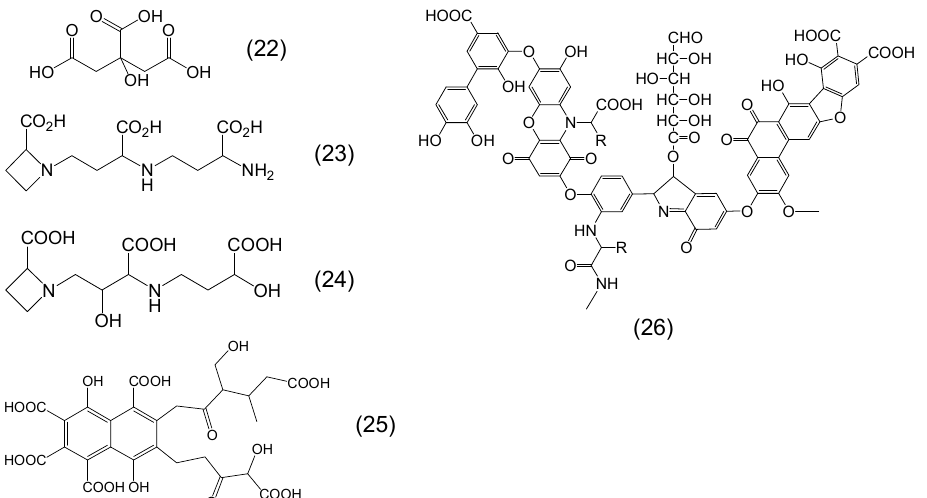
Figure 7. Examples of phytochelators containing the carboxylic acid as the metal binding site. Citric acid or 2-hydroxypropane-1,2,3-trioic acid ( 22 ), nicotianamine or N -( N -(3-amino-3-carboxypropyl)-3-amino-3-carboxypropyl)azetidine-2-carboxylic acid ( 23 ), mugineic acid or (2 S )-1-[(2 S ,3 S )-3-carboxy-3-[[(3 S )-3-carboxy-3-hydroxypropyl]amino]-2-hydroxypropyl]azetidine-2-carboxylic acid ( 24 ), fulvic acid or 3,7,8-trihydroxy-3-methyl-10-oxo-1,4-dihydropyrano[4,3-b]chromene-9-carboxylic acid ( 25 ) and humic acid ( 26 ).